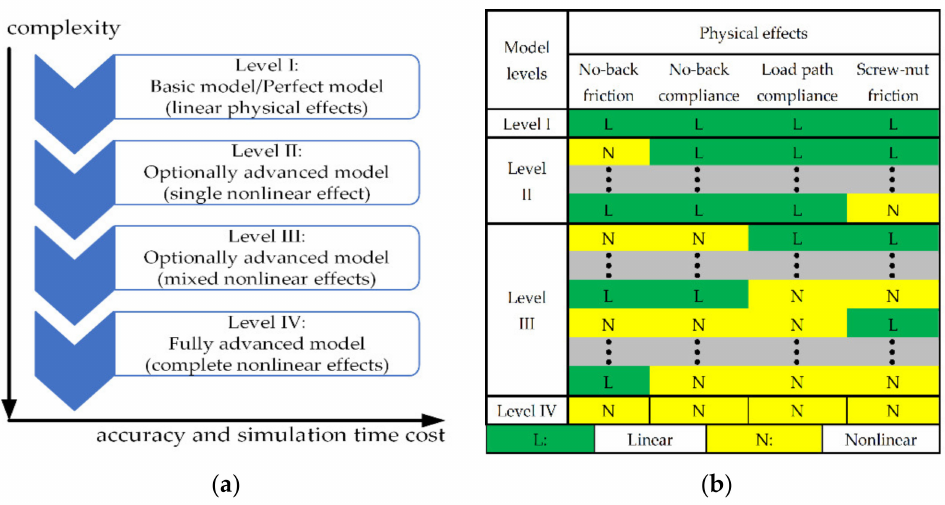
Figure 2. Multi-level modelling with incremental methodology. ( a ) Model complexity versus accuracy and simulation time cost; ( b ) Potential model matrixes with different levels for